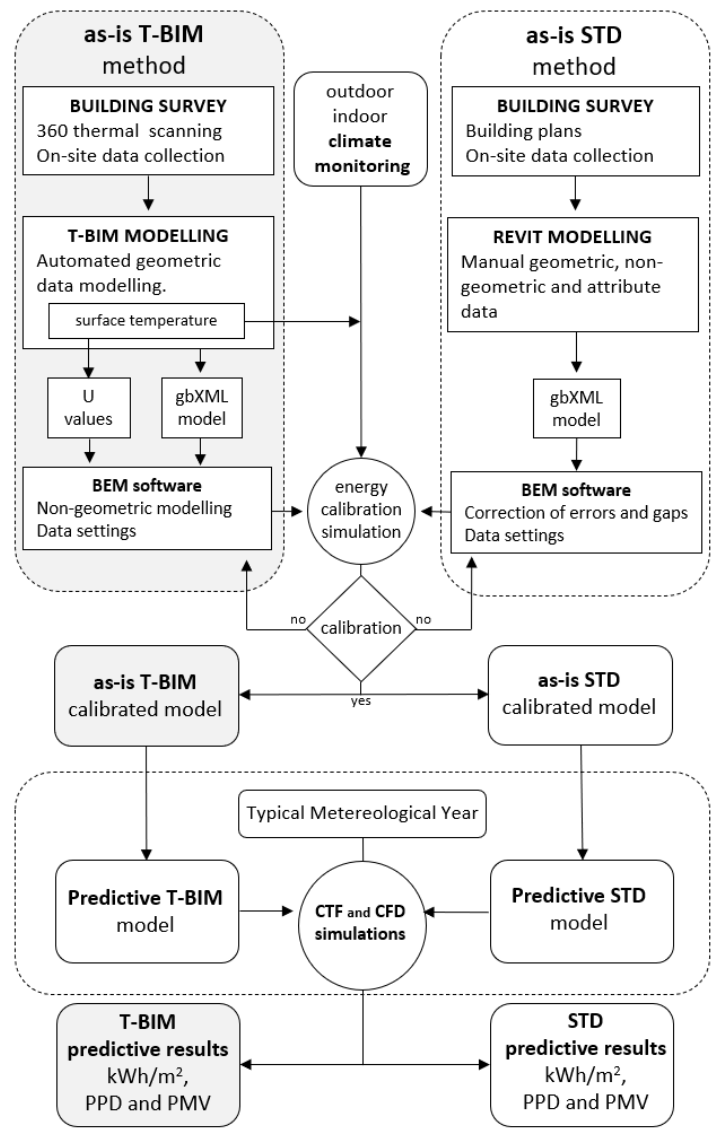
Figure 1. Diagram of research procedures and results.